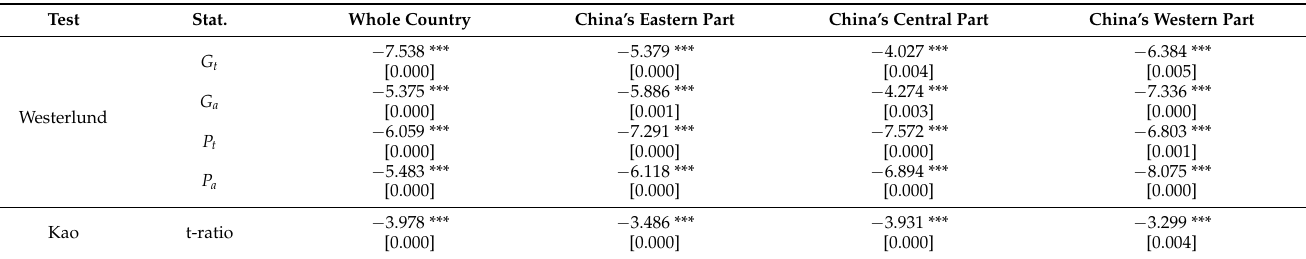
Table 4. Results of panel